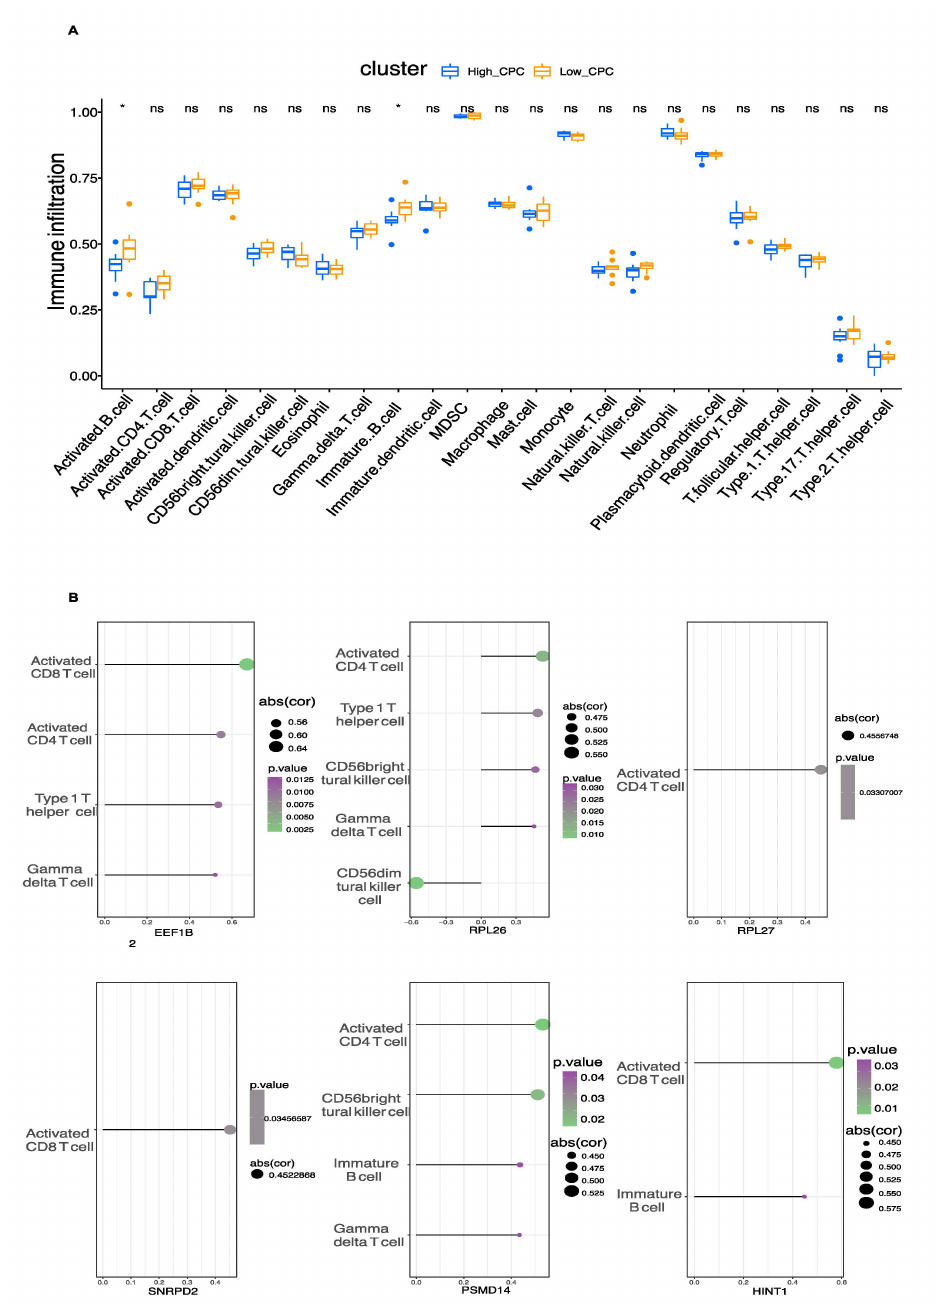
Figure 5. Immune cell infiltration. ( A ) The differences in the level of infiltration of 23 immune cells between the high and low CPC score groups. ( B ) The correlation of the hub genes with the level of infiltration of 23 immune cells was indicated. * p <